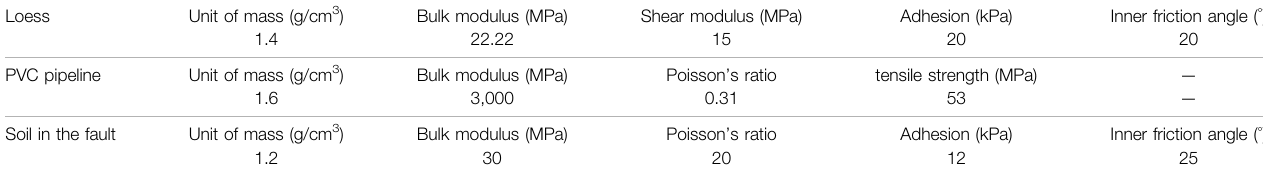
TABLE 2 | Physical and mechanical properties of loess from the test.